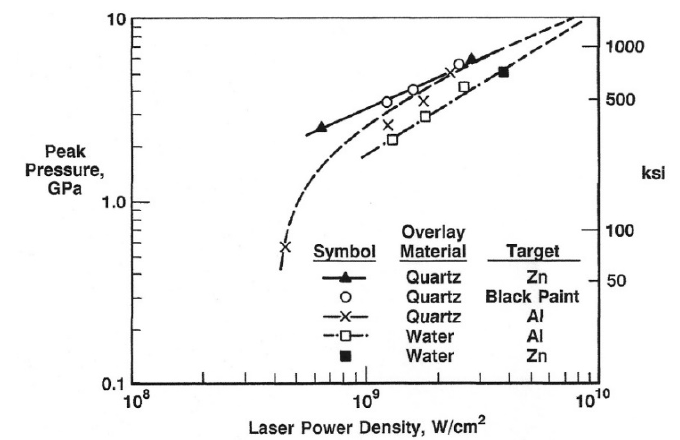
Figure 6. Comparison of predicted and measured pressures for aluminum, zinc and black paint confined by quartz and water overlays. The data points are experimental measurements. The curves are predicted by the LILA code [21].